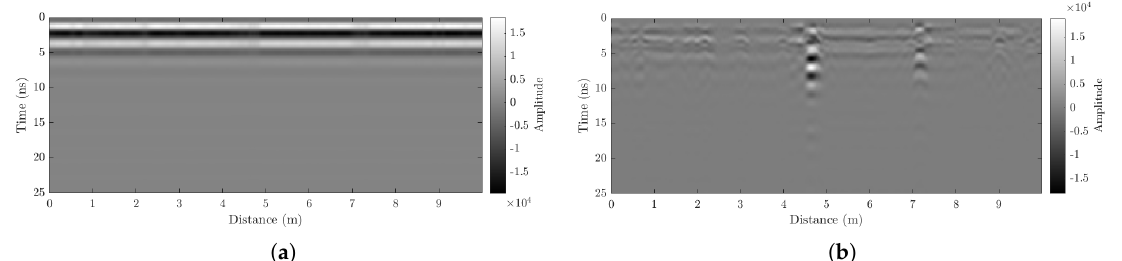
Figure A1. Substructures identified as unwanted signal and removed from the example GPR image shown in Figure 2. ( a ): The first eigenimage contains the most dominant substructures from a given GPR image—the direct wave. Horizontal banding is also a dominant structure in this example profile. ( b ): The second through fifth eigenimages contain the ringing produced by the railroad ties. ( a ) First Eigenimage from Example Profile. ( b ) Second through Fifth Eigenimage from Example